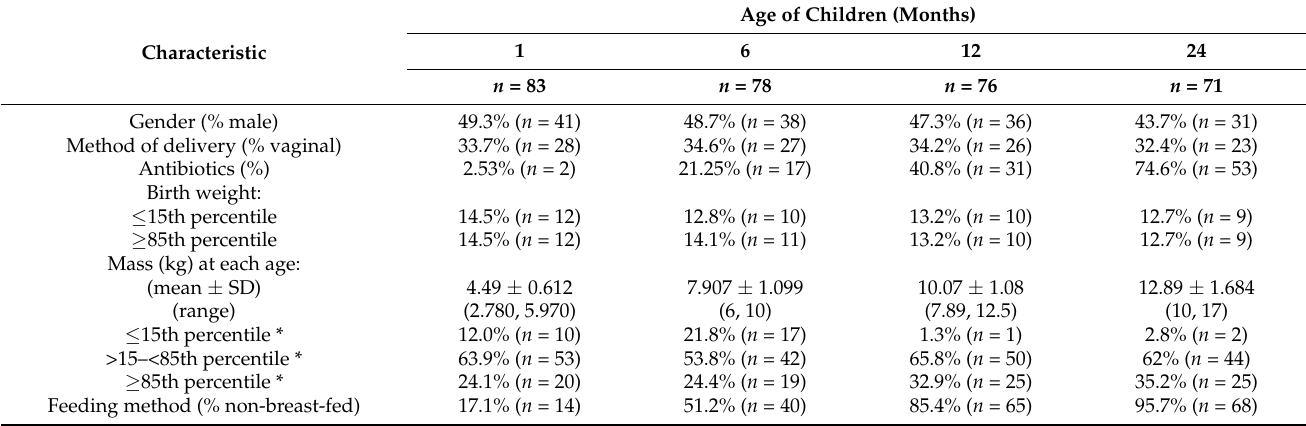
Table 2. Group characteristics: children up to 24 months